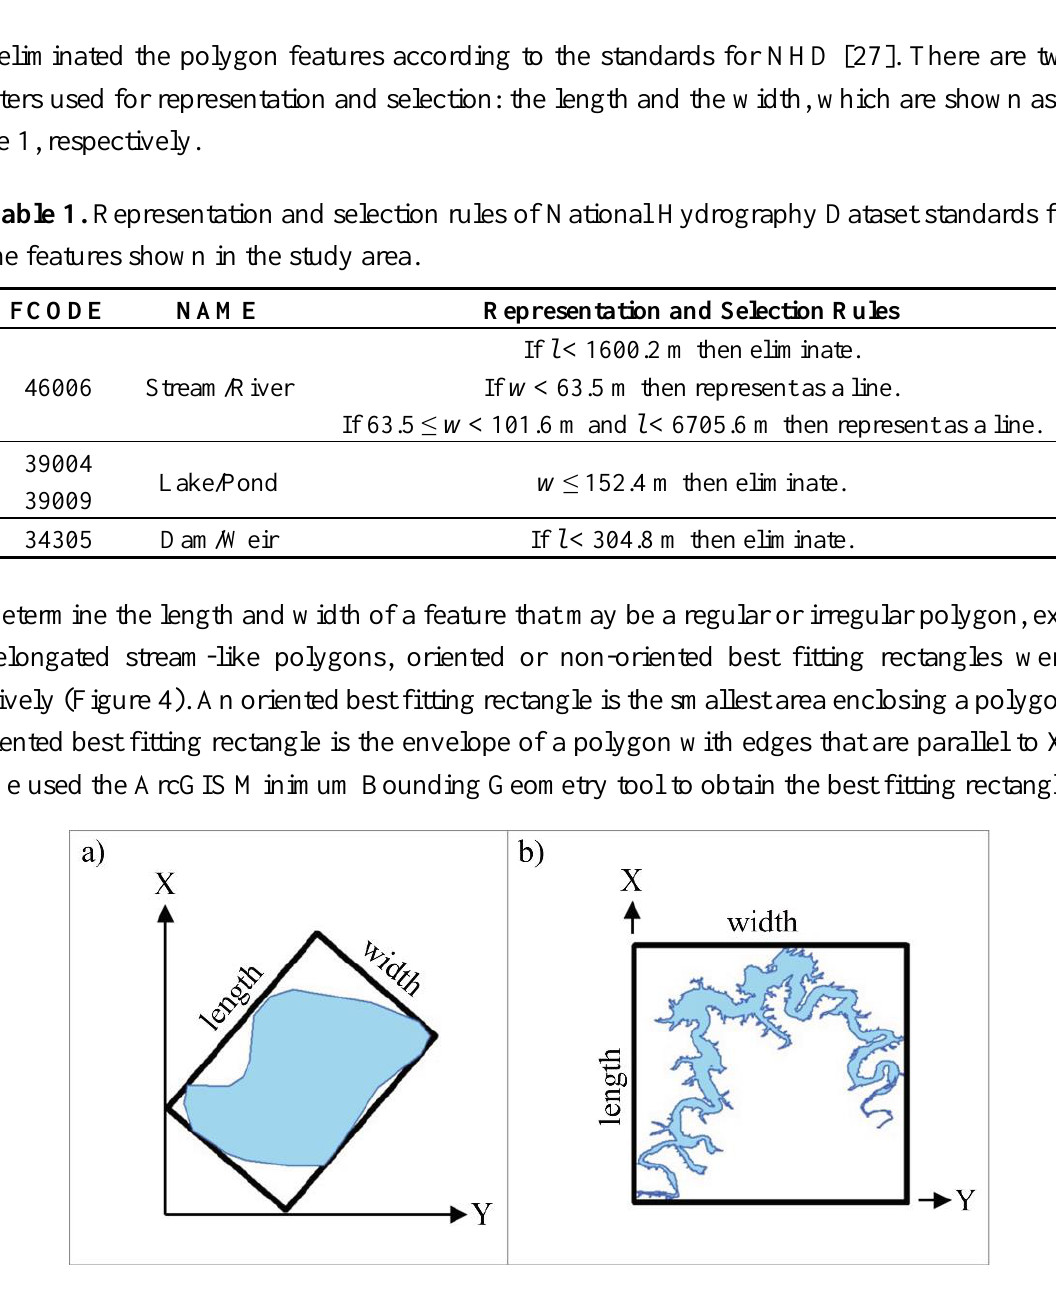
Figure 4. Best fitting rectangles. ( a ) Oriented for a regular polygon. ( b ) Non-oriented for an irregular